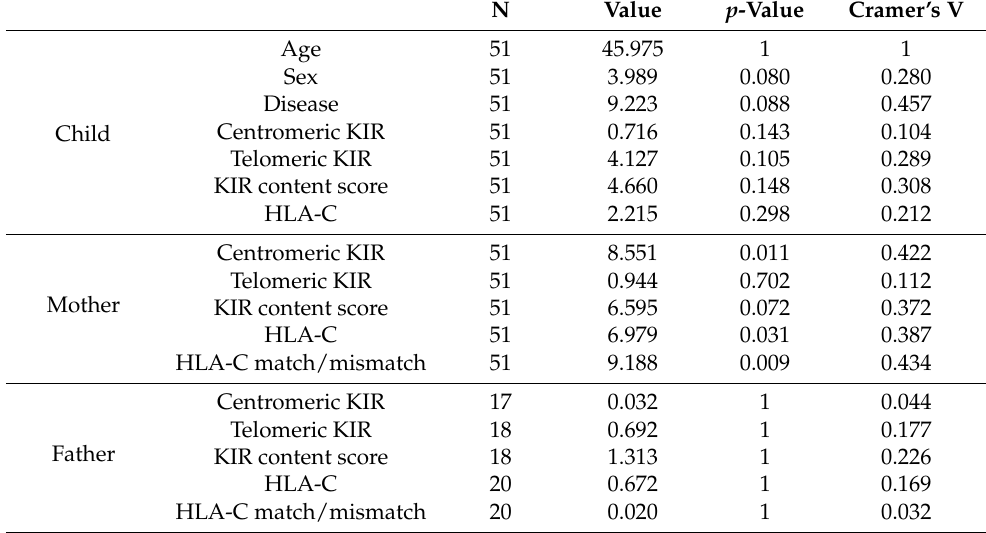
Table 2. Correlation of genetic factors in mother, child, and father with the occurrence of FM. Samples were grouped depending on age, sex, disease, centromeric or telomeric KIR genes, KIR gene content and HLA-C genotype. Differences in FM + and FM − groups were analyzed using Fisher’s exact test for two groups or Chi 2 for more than two groups followed by Cramer’s V to determine the strength of association (0.1 small effect, 0.3 medium effect, 0.5 large effect). Significance level p < 0.05.